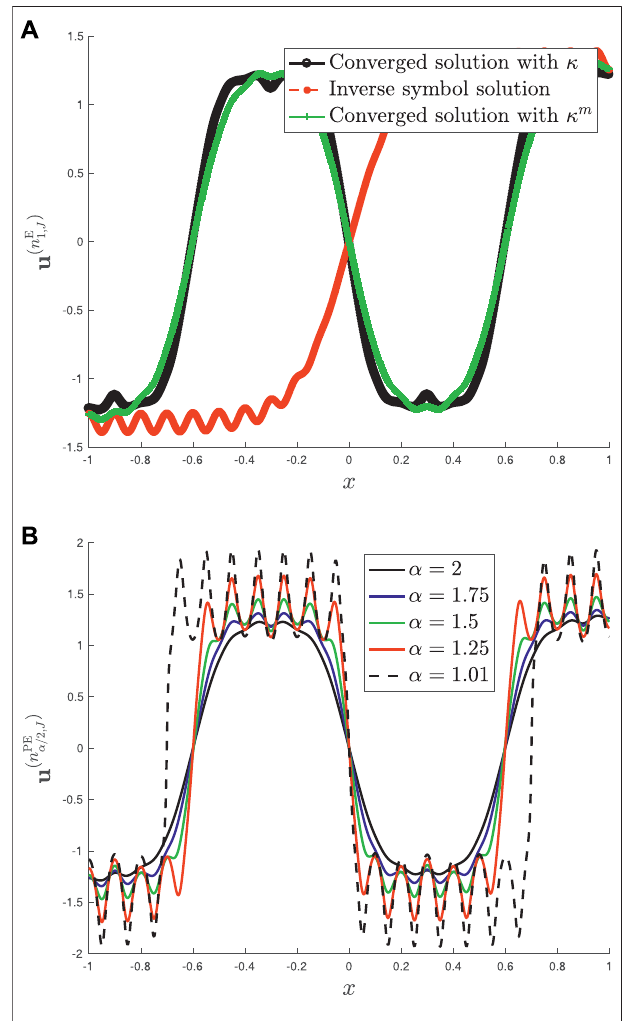
FIGURE 1 | 1d case: (A) ( α = 2 ): converged solutions for 1) the variable coef fi cients case with the unpreconditioned Euler scheme and variable function κ , 2) with the direct inversion of the operator by using the variable function κ and 3) with the Euler scheme by using the average constant κ m . (B) : converged solutions for various values of the fractional order α